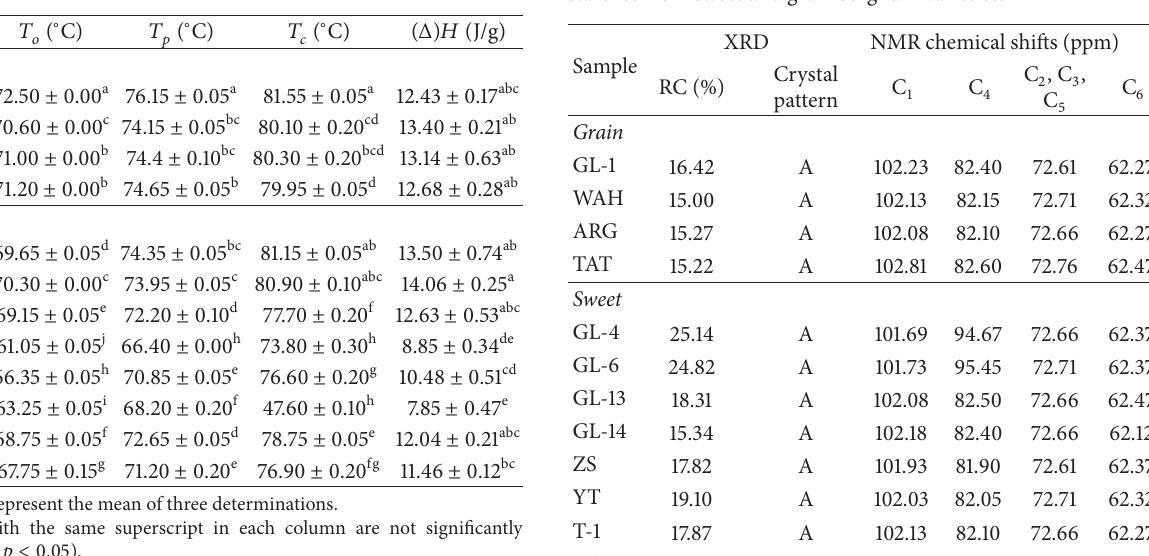
Table3:Thermalpropertiesofstarchfromsweetandgrainsorghum varieties.